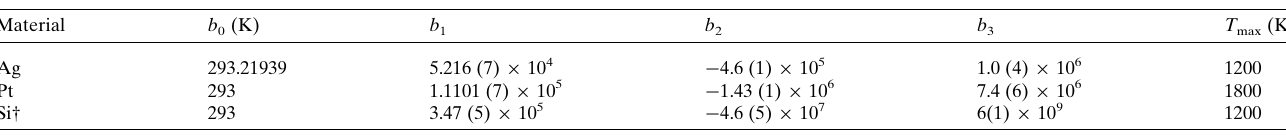
Table 1 Coefficients for the calibration function refined from thermal expansion data from Kirby et al. (1977). T max refers to the maximum measured temperature in the data. Material